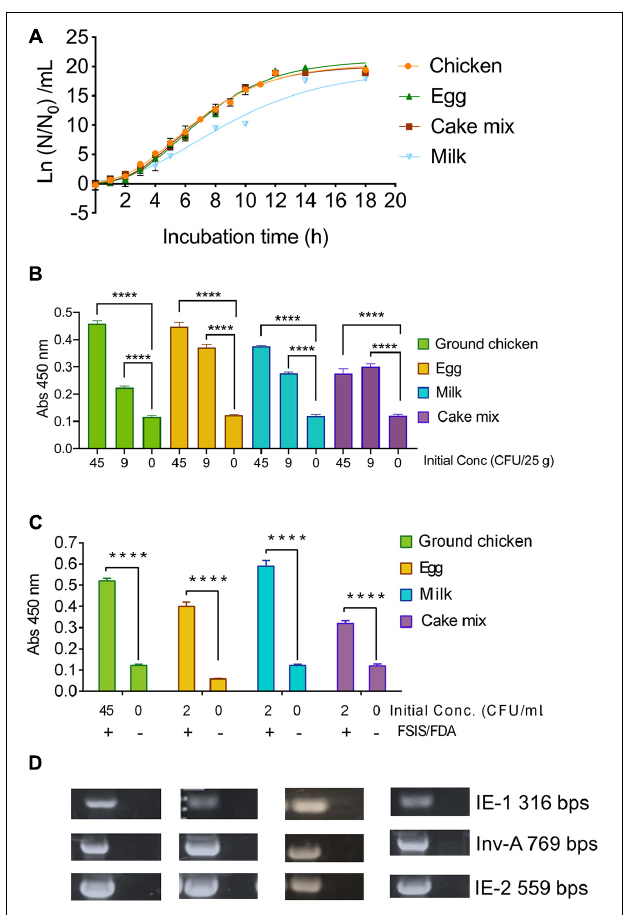
FIGURE 6 | Mammalian cell-based immunoassay validation with inoculated food samples. (A) Growth curve of S. Enteritidis PT21 in various food products suspended in buffered-peptone water (BPW) at 37 ◦ C. Before growth analysis, inoculated food samples were held at 4 ◦ C for 24 h. The best-fit curves for Salmonella growth in different foods were generated by using the Gompertz model. R 2 values of each fitted Gompertz curve are 0.99 (Chicken), 0.99 (Egg), 0.99 (cake mix) and 0.96 (Milk). N 0 , initial S. Enteritidis concentration; N, S. Enteritidis concentration at the corresponding time point. MaCIA results of S . Enteritidis inoculated (at 0, 9, 45 CFU/25 g) (B) and at 0, 2, 45 CFU/mL (C) food samples after 14–19 h enrichment. (D) PCR confirmation of S. Enteritidis targeting Salmonella specific genes. Error bars represent SEM. **** P <